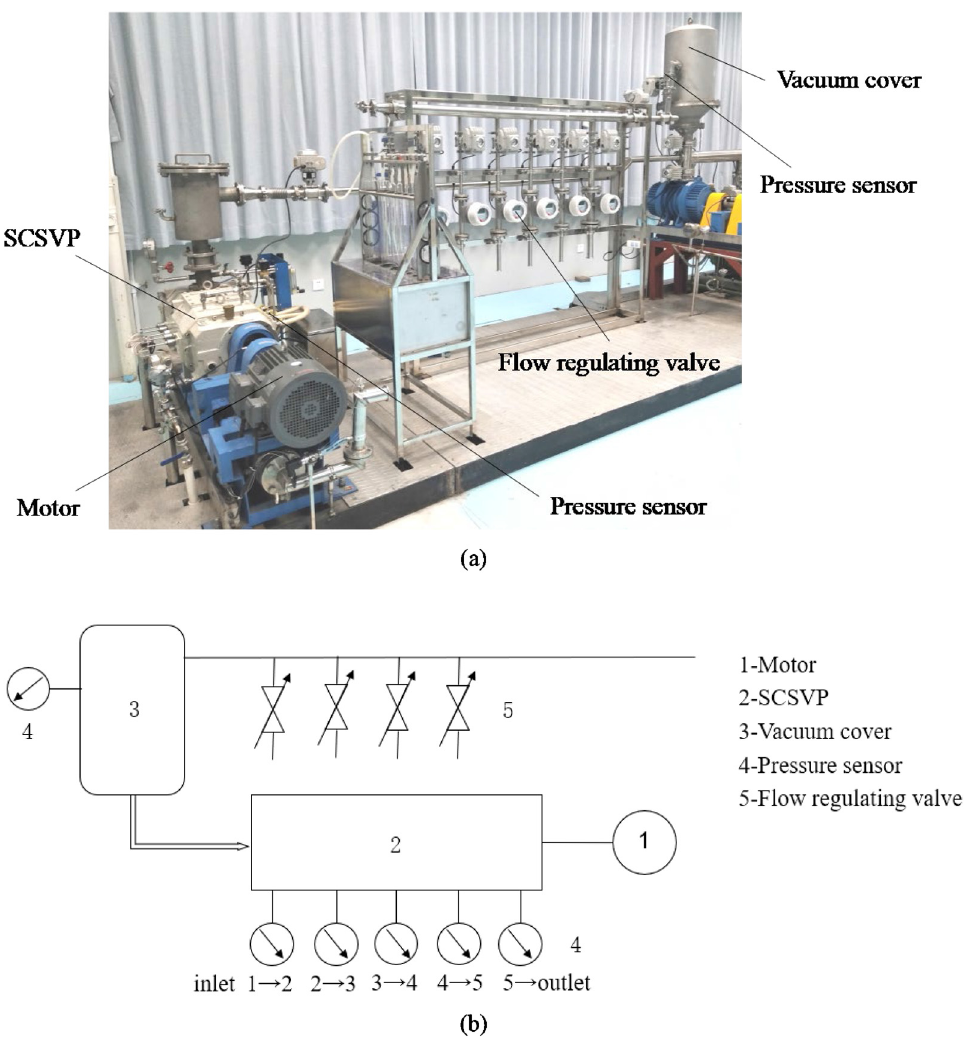
Fig. 8. The test platform of screw vacuum pump (a) and its schematic design (b).